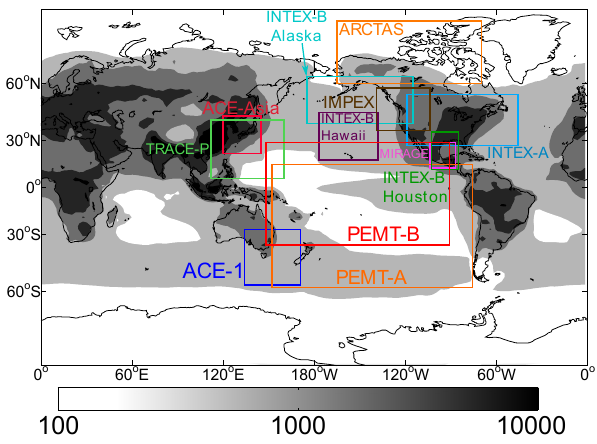
Figure 4. Locations of flight observation campaigns used in this study. The regions and flight observation data are from Clarke and Kapustin (2010). Background colour corresponds to aerosol number concentration (cm − 3 ) in simulation